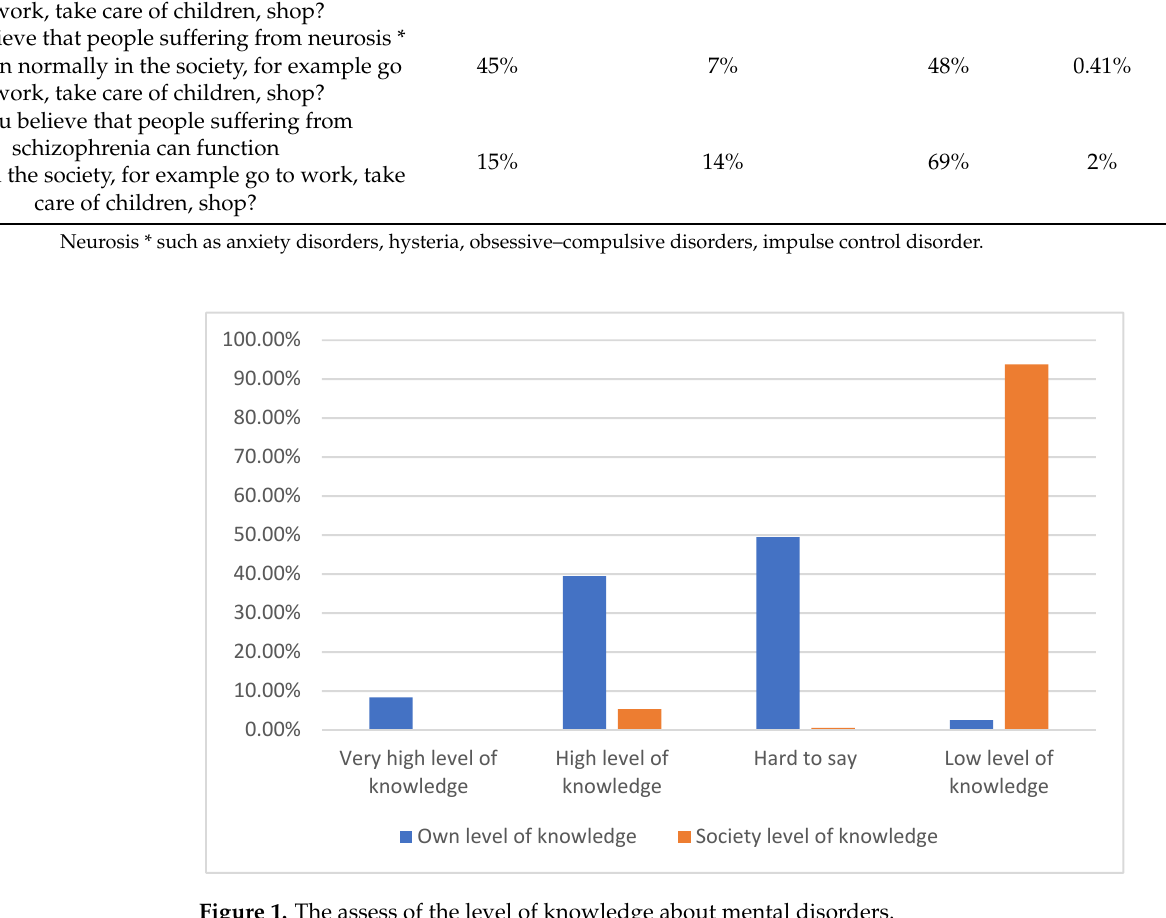
Table 3. Distribution of answers regarding the ability to function in the society.